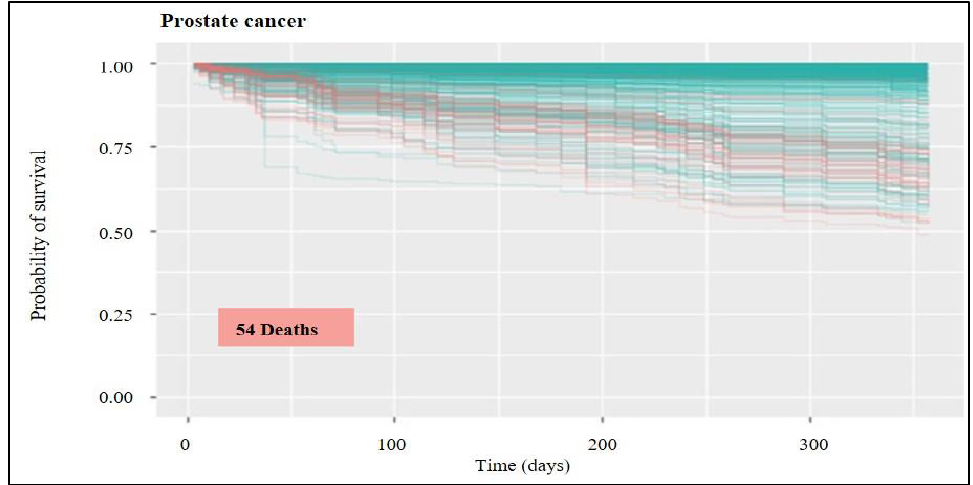
Figure 6. Survival for prostate cancer: probability of survival over time for the untrained group of patients (out-of-bag group). In red lines is the prediction of death occurrences; in blue is survival.